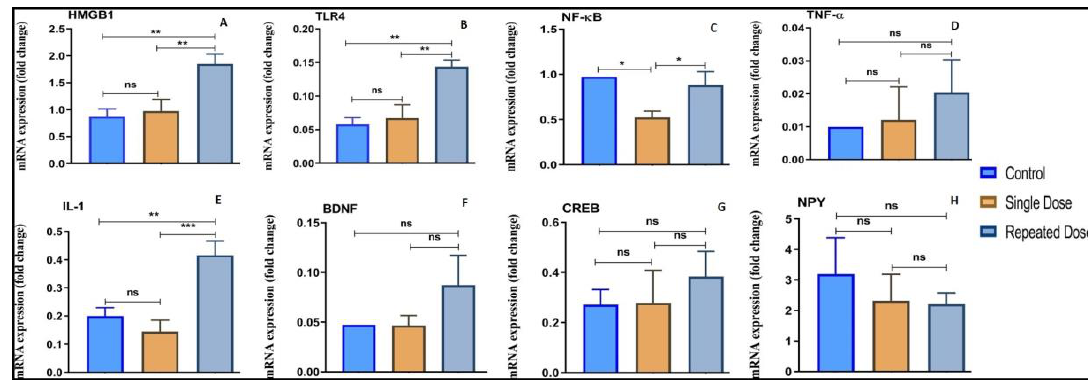
Figure 6. Modulation of inflammatory (HMGB1, TLR4, NF- κ B, TNF- α , and IL-1) and other markers (BDNF, CREB-1, and NPY). Expression level of inflammatory (HMGB1, TLR4, NF- κ B, TNF- α and IL-1) and other markers (BDNF, CREB-1, and NPY) in the brain as determined by real time-PCR. The genes included are ( A ) HMGB1, ( B ) TLR4, ( C ) NF- κ B, ( D ) TNF- α , ( E ) IL-1, ( F ) BDNF, ( G ) CREB-1, and ( H ) NPY. All changes in the expression levels were compared to the repeated dose of pilocarpine (pilocarpine 400 mg / kg). Data are expressed as mean ± SEM, n = 6 and statistical analysis by one-way ANOVA followed by Sidak’s multiple comparison test, * p < 0.05, ** p < 0.01, and *** p < 0.001.